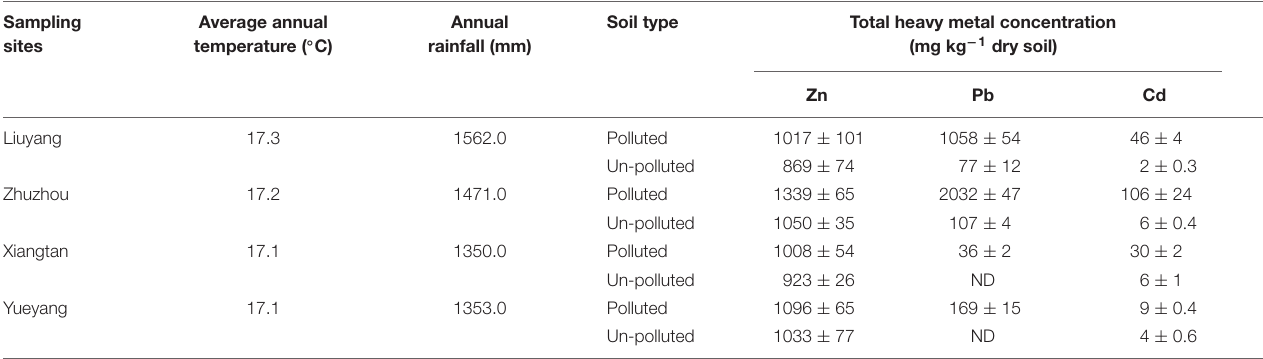
TABLE 1 | The climatic and soil conditions of polluted areas in Hunan province. Sampling